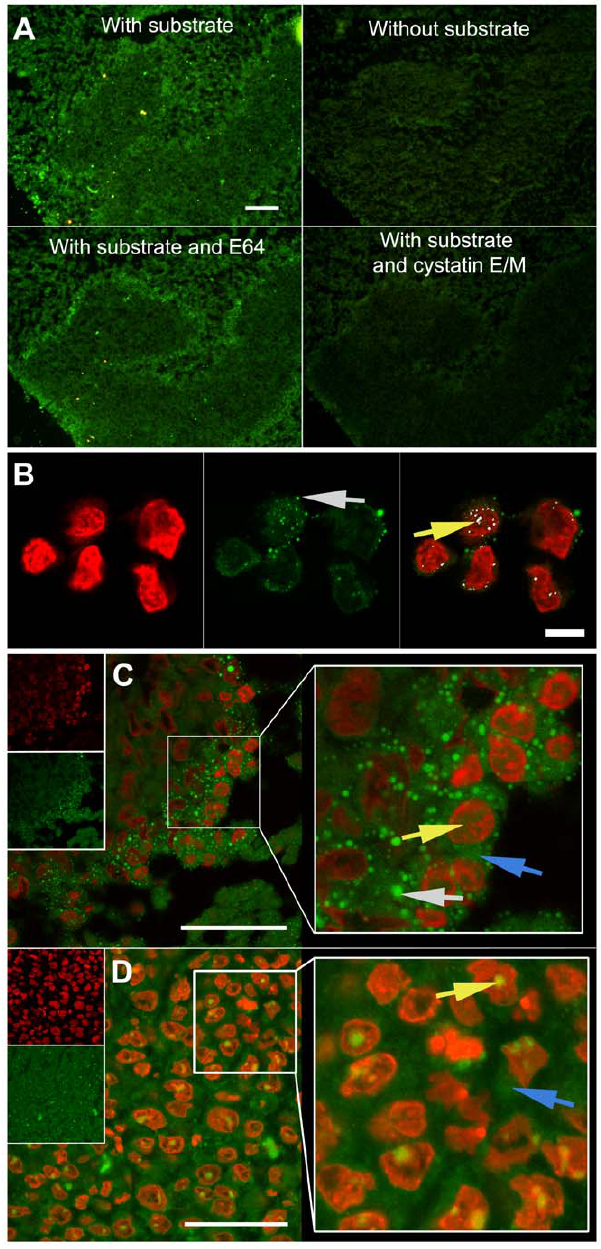
Figure 6. In situ legumain activity in cultured cells and subcutaneous xenografts. (A) In situ proteolytic activity (green) captured by fluorescence microscopy imaging of adjacent cryosections from a HCT116 subcutaneous xenograft incubated with (top left) and without (top right) legumain substrate, legumain substrate and E64 (lower left) or legumain substrate and recombinant cystatin E/M (lower right), demonstrating the specificity of the synthetic peptide Suc-Ala- Ala-Asn-NHNapOME utilized as legumain substrate. All pictures were taken using true colors, after the same incubation time and with identical microscope and camera settings. Scale bar represents 100 m m. Subcutaneous xenografts with SW620 cells (Fig. S3J). (B) Subcellular localization of active legumain (green) in HCT116 cells (made from cryosections after mounting in OCT-medium) with nuclei stained by DAPI (red) and analyzed by confocal laser scanning microscopy. This showed granulated activity inside (yellow arrow) and outside (gray arrow) of the nucleus. Localization in the nucleus was confirmed by co- localization (white) of legumain activity and the nuclear counter-stain (right panel). Scale bar represents 10 m m. HCT116 cells incubated